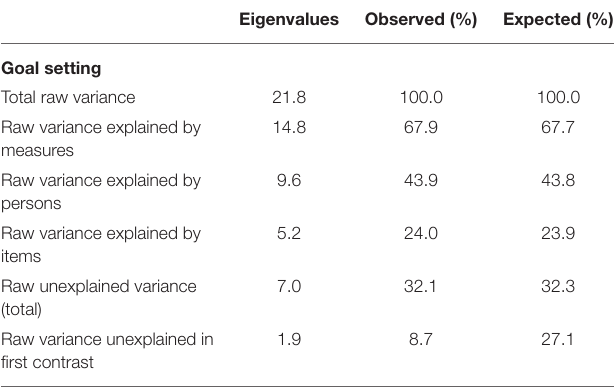
TABLE 2 | Variance of standardized residuals.